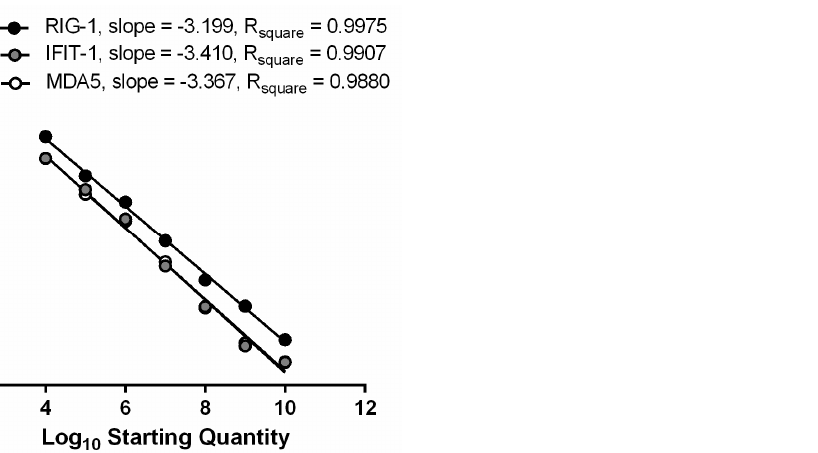
Figure 1. Determination of amplification efficiencies of RIG-1, MDA5, and IFIT-1 genes in mul- tiplex qPCR. Cq cycles versus log starting quantity were plotted to calculate the slopes. The corre- sponding qPCR efficiencies were calculated according to the equation E = 10 ( − 1/slope) − 1 .